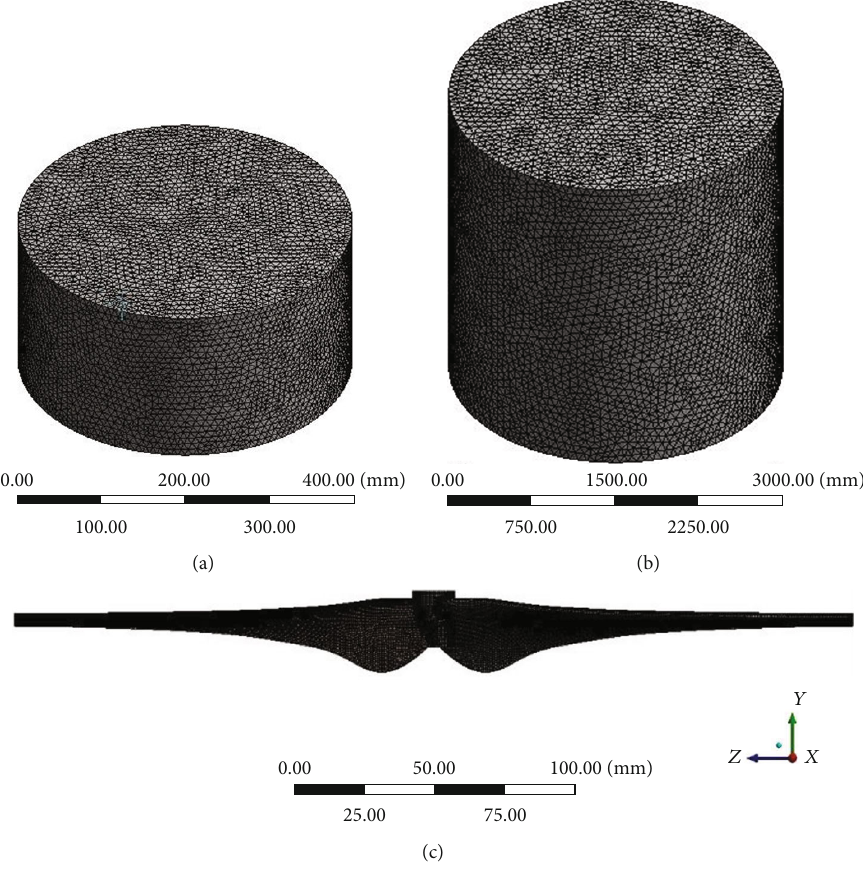
Figure 13: Mesh for (a) rotating domain, (b) stationary domain, and (c) propeller